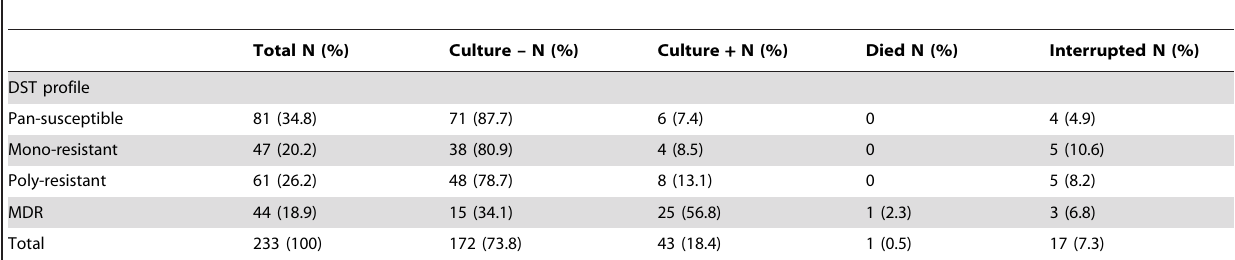
Table 3. Treatment outcome of the patients at the end of Category II treatment according to their DST profile at start of treatment.